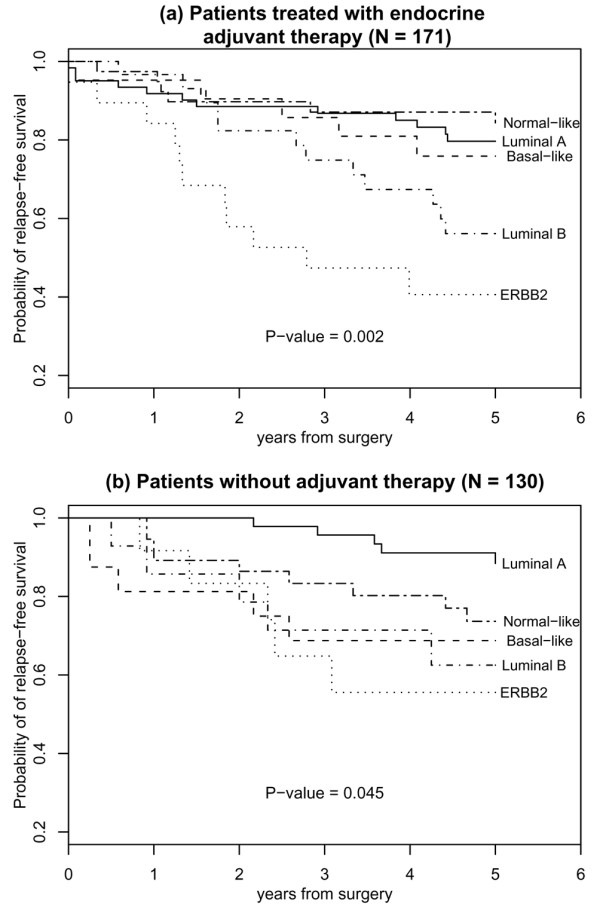
Kaplan-Meier relapse-free survival curves. Survival curves are shown for the tumor subtypes in (a) patients with endocrine therapy and (b) patients without any adjuvant therapy. The p value, computed with Cox regression, is for simultaneous comparison of all the curves.